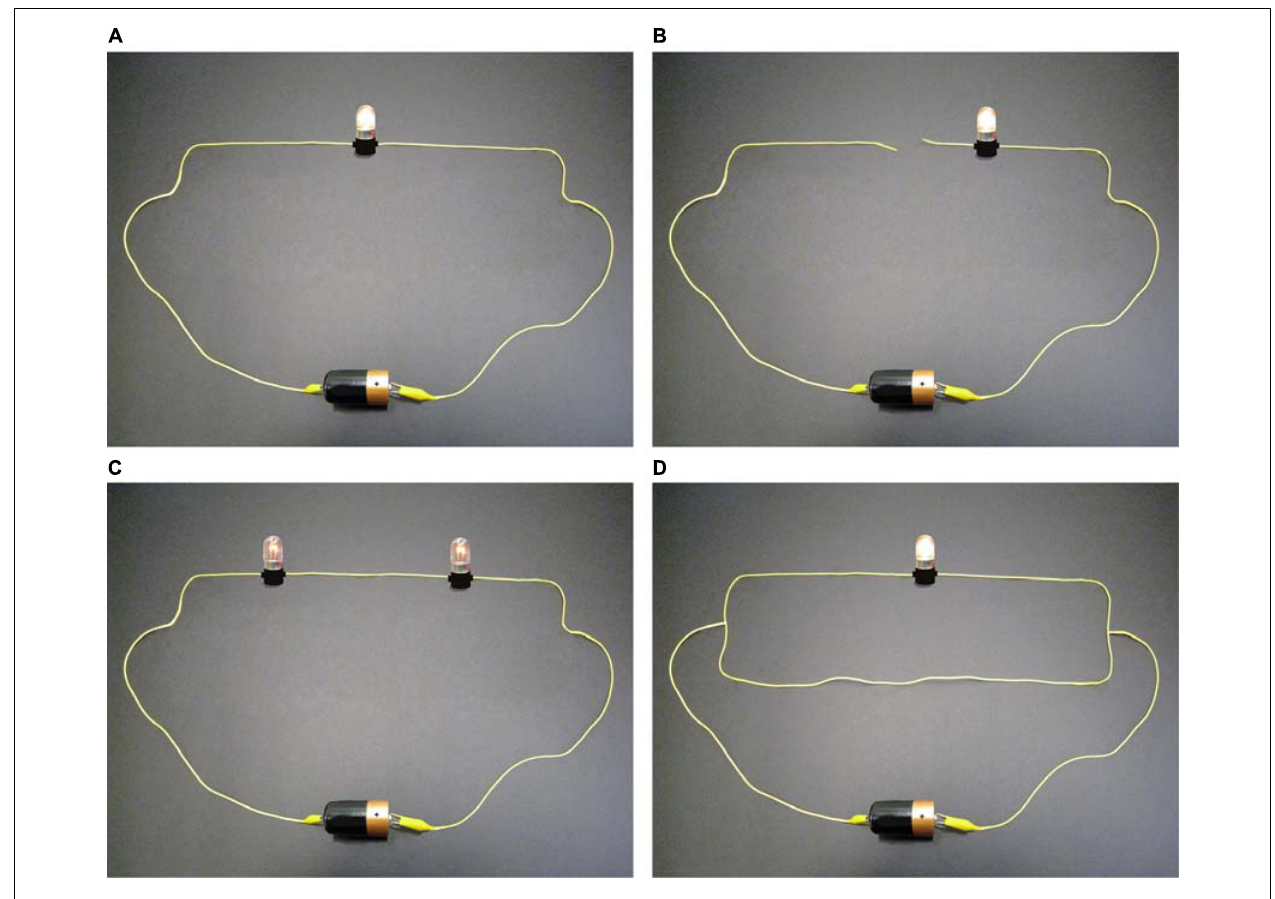
FIGURE 1 |A few examples of the electric circuits depicted in the experiment. Scientifically correct and incorrect circuits were presented and, for each one, participants had to indicate, based on their own opinion,